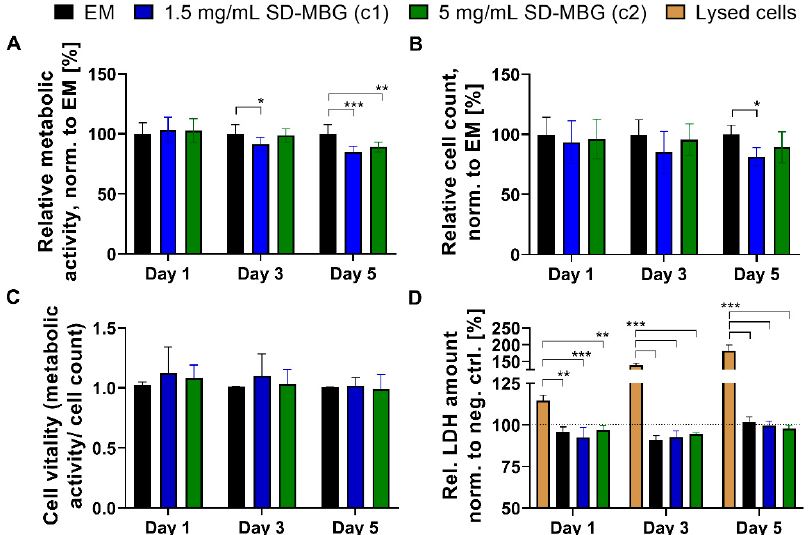
Figure 3. Cytocompatibility upon indirect exposure of hMSCs to SD-MBGs for one, three and five days. ( A ) Metabolic activity using Presto Blue and measuring substrate conversion by the cells. ( B ) Cell count as determined by DAPI-staining, imaging of the wells (two 3 × 3 mosaic images per well using 10 × magnification taken at slightly ex-centrical positions) and counting the nuclei using FIJI ImageJ software. ( C ) Cell vitality calculated by building a ratio of metabolic activity and cell count, indicating the viability per cell. ( D ) Relative lactate dehydrogenase (LDH) content in the supernatant compared to fresh culture medium serving as negative control and set to 100%. Cells cultured in expansion medium (EM) were lysed at each testing time point and were used as positive control to estimate the maximal amount of LDH that could be secreted into the supernatant. Normalization per time point as stated in the axis titles, n = three hMSC from di ff erent donors with four technical replicates each. One-way ANOVA with Dunnett’s multiple comparison test was performed using the positive control (EM: ( A – C ); lysed cells: ( D )) as comparator. EM: cells cultured in expansion medium, hMSCs: human mesenchymal stromal cells, SD-MBG: spray-dried mesoporous bioactive glasses, c1: concentration 1 (1.5 mg / mL), c2: concentration 2 (5 mg / mL), DAPI: 4 (cid:48) ,6-diamidino-2-phenylindole. p -values for statistical